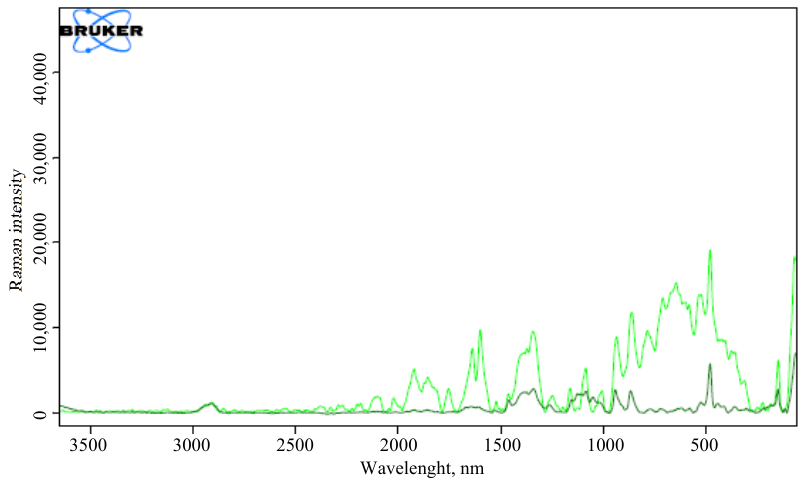
Figure 9. Fluorescence spectra ( image above ) and RAMAN spectra ( image below ) for the dirty (dark green) and washed (light green) potato tubers of the Udacha variety. The overall intensity is higher for the washed potato tubers both for fluorimetric and RAMAN spectra; the spectrum of the dirty sample is noisier in fluorescence but lower and weaker for RAMAN. However, the spectrum envelope is the same in both cases. This fact suggests that the contamination does not distort the spectrum, and the dirty potatoes can